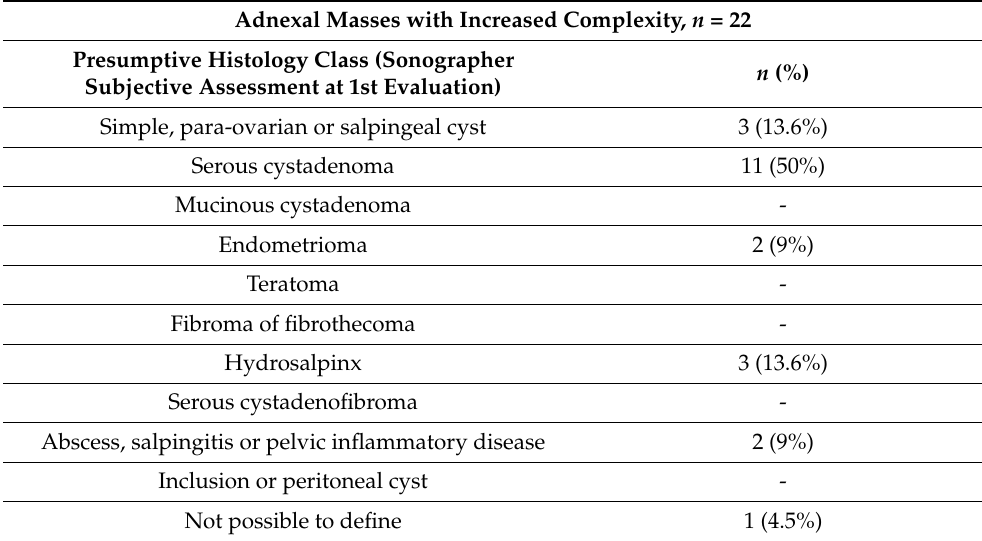
Table 5. Adnexal masses showing increased sonographic morphological complexity during